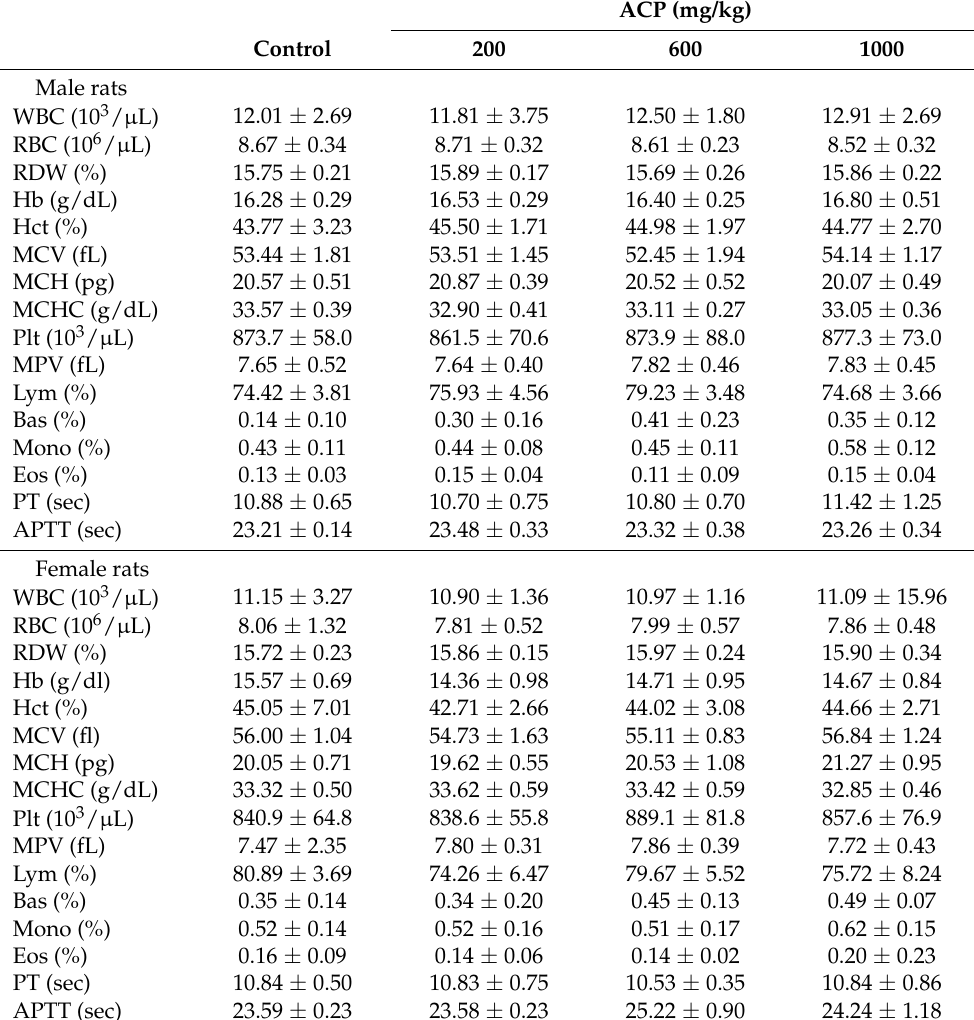
Table 3. Hematological parameters of male and female rats treated with or without ACP for 90